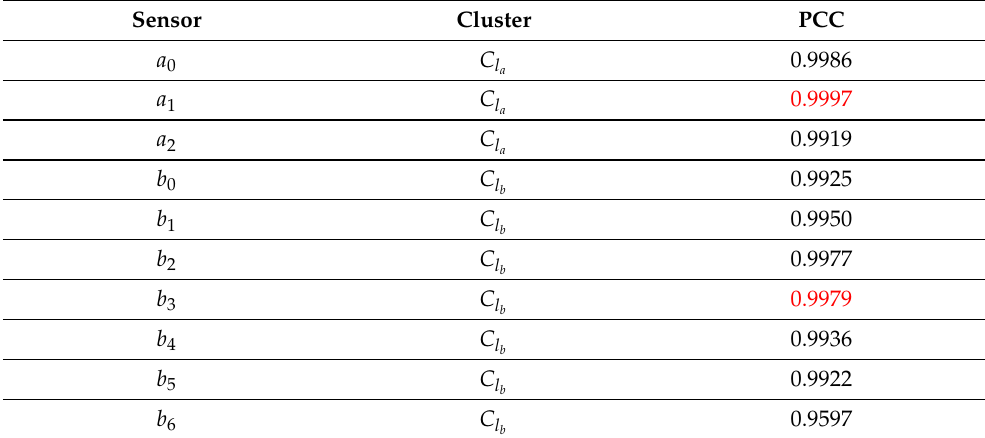
Table 1. Results for selecting one sensor in dataset L . The red PCC scores indicate the winners of each